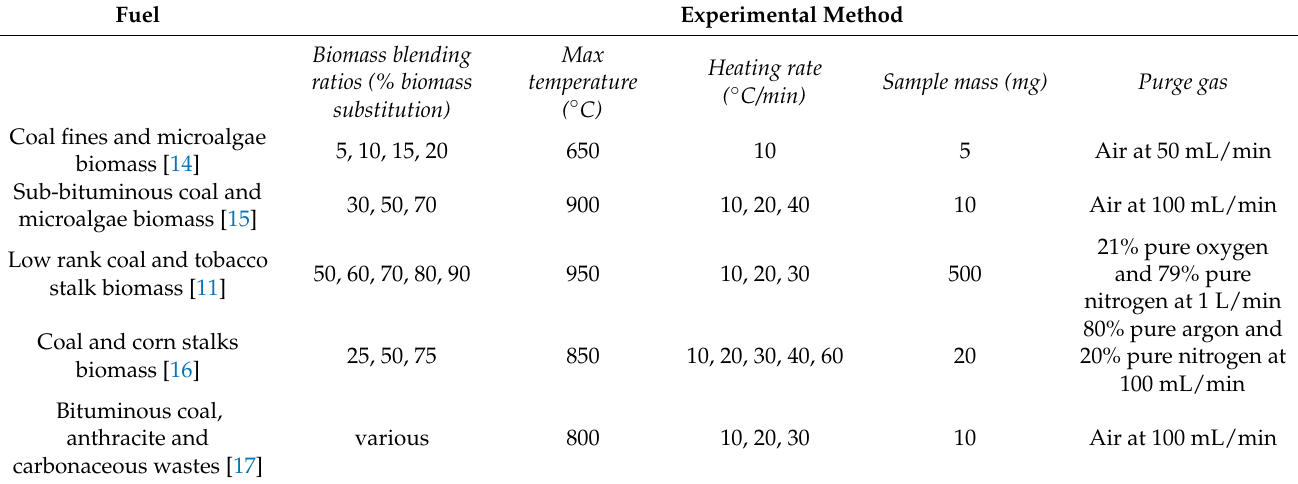
Table 1. Examples of coal and biomass cocombustion analysis by use of thermogravimetry.